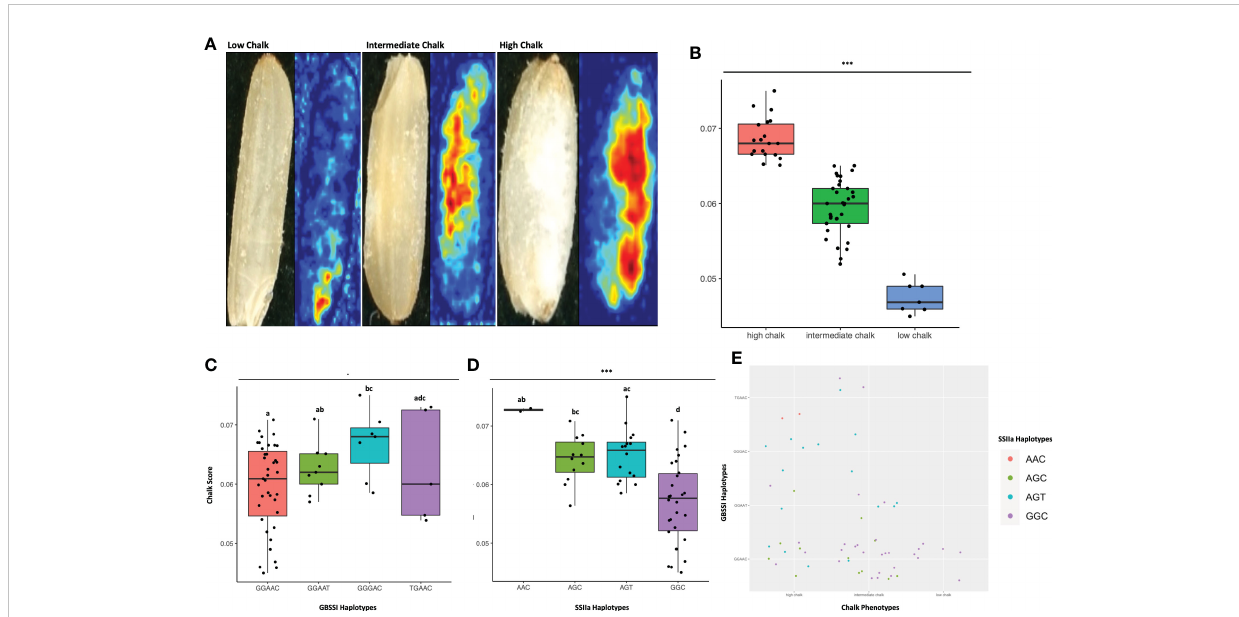
FIGURE 7 Haplo-pheno analysis of Granule Bound Starch Synthase I and Starch Synthase II (A) . (A) Rice seed scans and their corresponding heat maps highlighting the chalky area (red) in less chalk, intermediate chalk and high chalk seed types. (B) Box plot depicting the chalky score of 25 rice genotypes (grown in two crop seasons) categorized as high, intermediate and low chalk. (C) Box plot of the chalk score data categorized according to the GBSS I haplotypes. (D) Box plot of the chalk score data categorized according to the SSIIa haplotypes. (E) Comparison of the haplotypic combination of GBSS I and SSIIa. One-way ANOVA was conducted for determining the statistical signi fi cance of haplotype means. Chalk score data designated with the same alphabet are not signi fi cantly different at p ≤ 0.05 (*) or p ≤ 0.01 (**) or p ≤ 0.001 (***) as per Tukey Post hoc test for Honest Signi fi cance Difference (HSD)